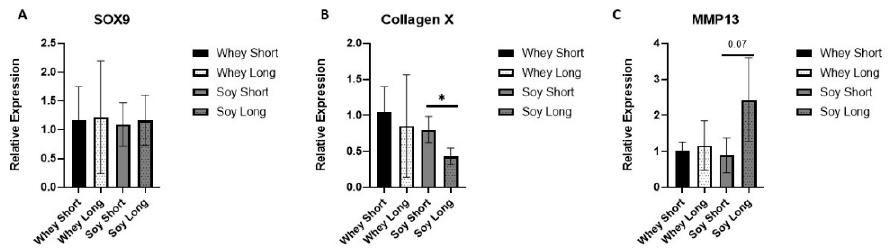
Figure 6. The effect of recovery from LPS-induced inflammation using the study diets on the relative expression of ( A ) SOX9, ( B ) collagen X, and ( C ) MMP13. Student’s t -test was used (two time points were compared per each group; * <0.05).